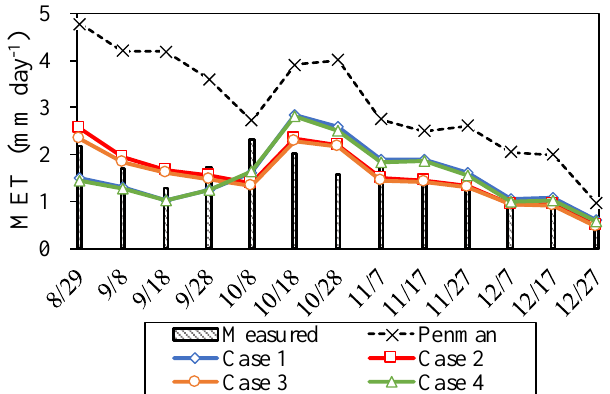
Figure 6. Comparison of simulated, measured and potential evapotranspiration at ten-day intervals (MET) from 29 August to 31 December 2009.